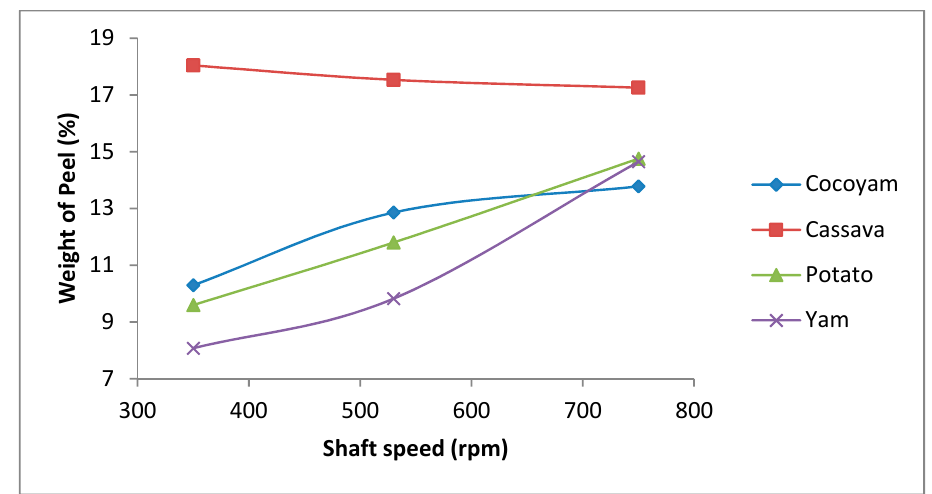
Figure 12. Effect of shaft speed on the percentage weight of peel.